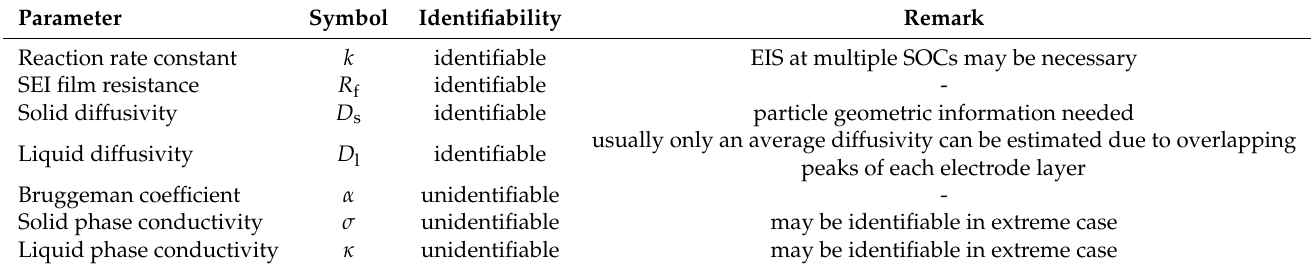
Table 2. Summary of parameter identifiability in the frequency